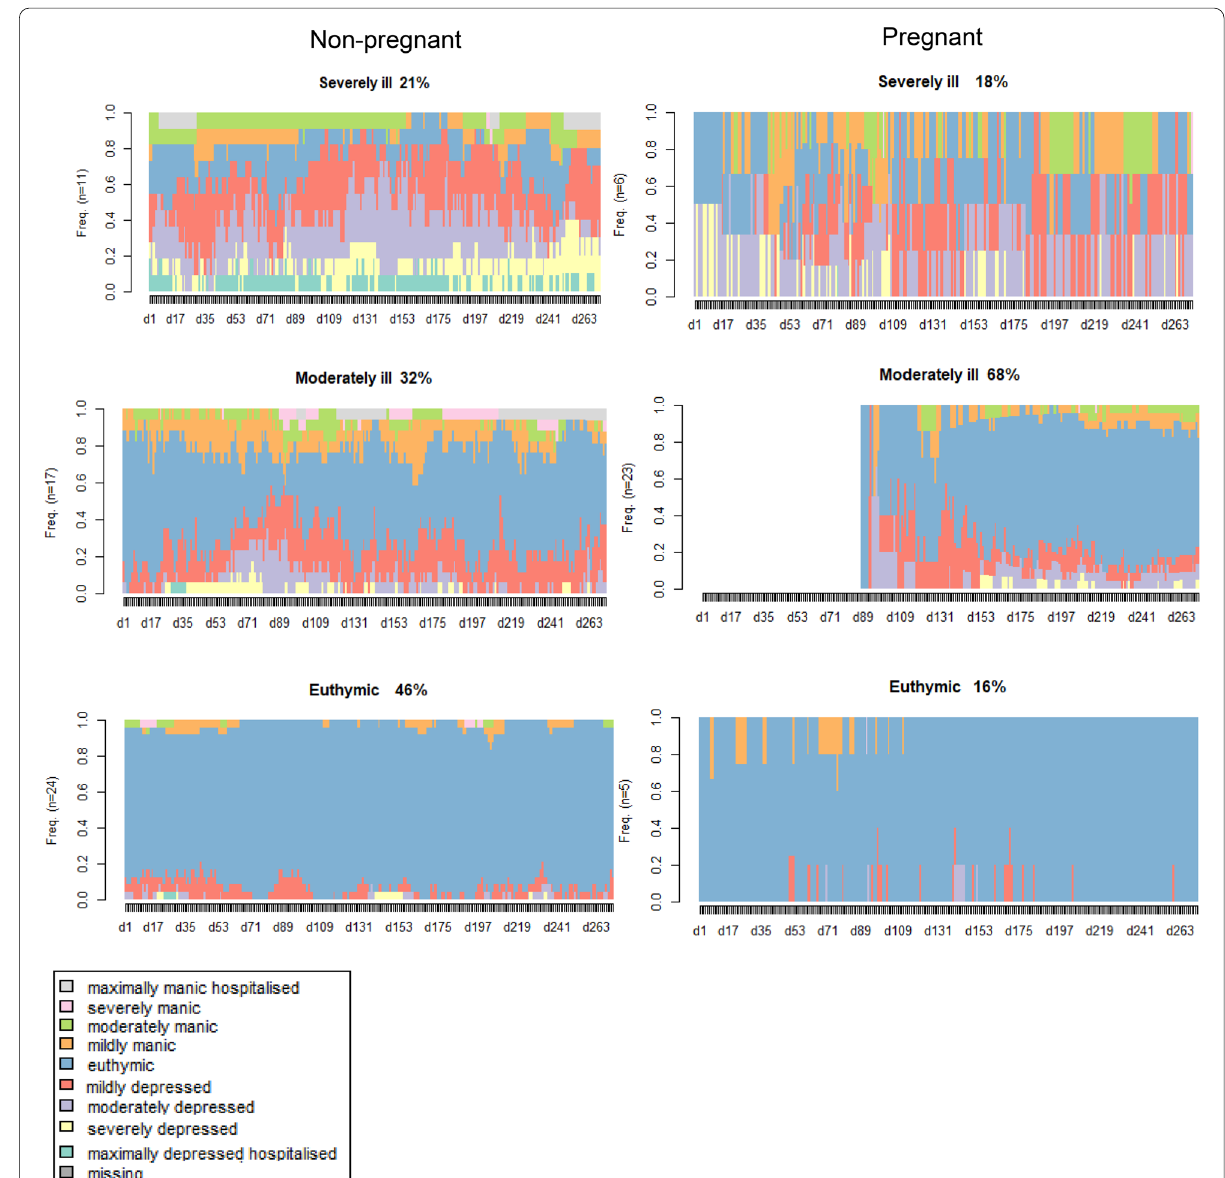
Fig. 2 Index plots of three cluster solution for the pregnant sample and non‑pregnant sample; X‑axis: time in days (d1 means dey 1), Y axis: proportions women distributed over states in